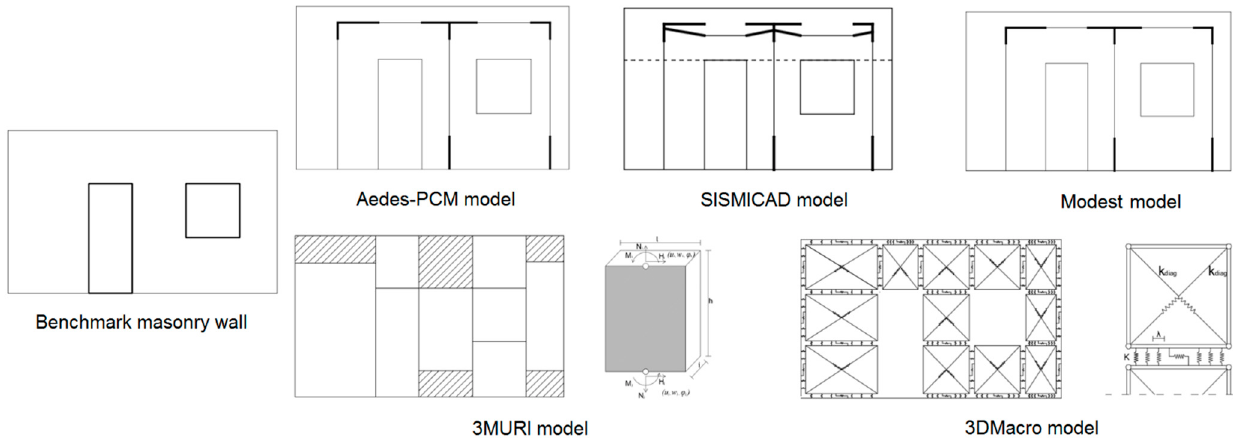
Figure 1. Examples of macro ‐ elements models for the benchmark masonry wall according to different software packages: Aedes ‐ PCM, SISMICAD, Modest, 3MURI, and 3DMacro.